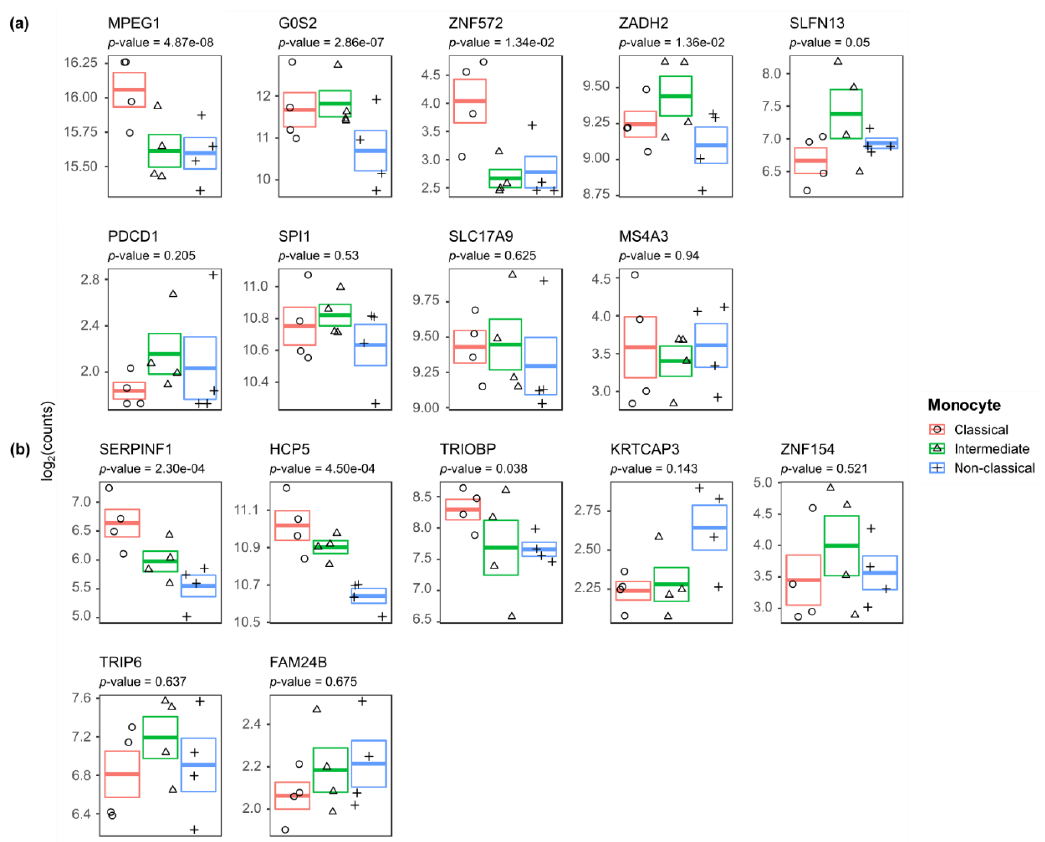
Figure 4. Gene expression of the ( a ) CD vs. non-CD and ( b ) CD-active vs. CD-remissive DMGs across the different monocyte subsets. Visualization of the log 2 (counts) with standard error for classical, intermediate and non-classical annotated with the p -value as obtained from the likelihood ratio test.